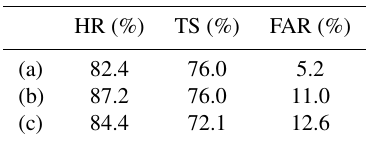
Table 2. Measures of forecast accuracy in terms of the hit rate (HR), threat score (TS), and false alarm rate (FAR); (a)–(c) are the same as in Fig. 1. The final row shows the values when the threshold of x(t i ) rule is